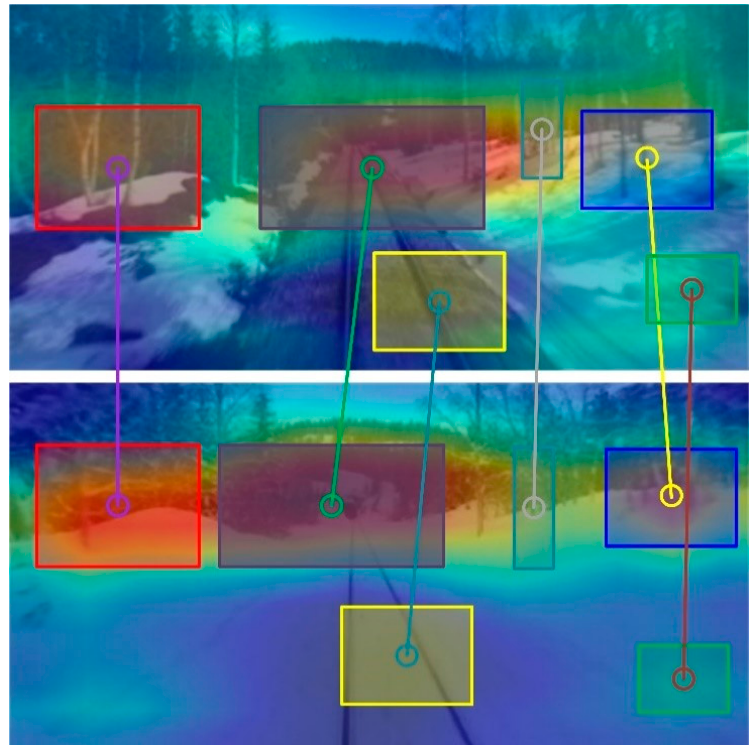
Figure 1. Robot recognizes the visited scene by matching local regions in a changing environment (e.g., Winter and Autumn). This method can be widely used to local region detectors, such as key points, segmentation method and object proposals. The rectangle of different colors represents the different position of interests.